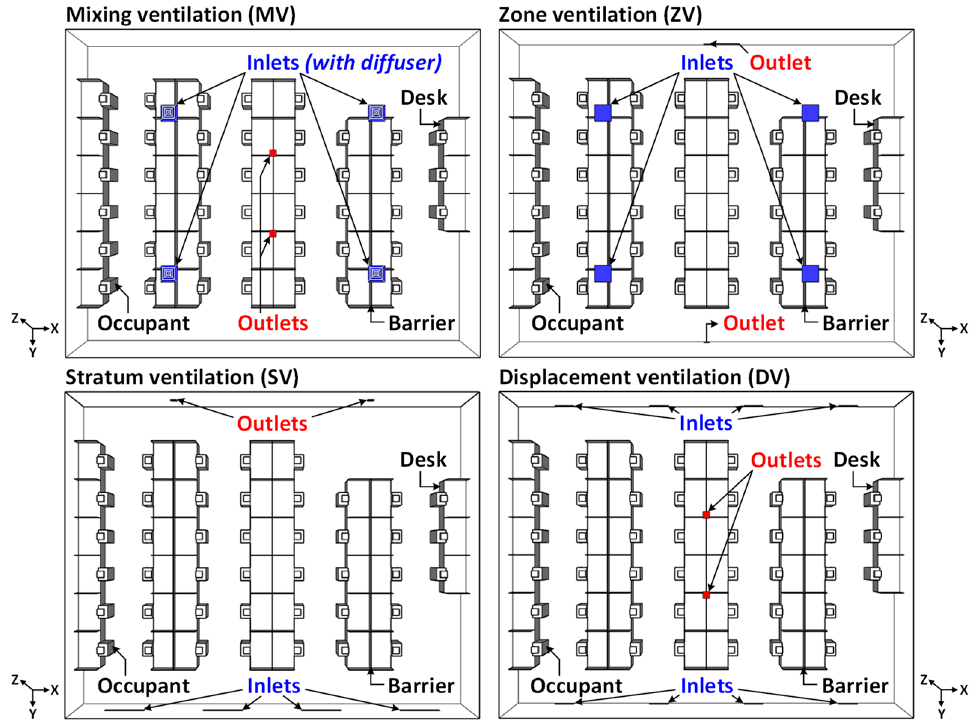
Figure 2. Schematic diagram of various ventilation modes in the office, including mixing ventilation (MV), zone ventilation (ZV), stratum ventilation (SV) and displacement ventilation (DV). Table 1. Information of inlets and outlets for different ventilation modes.